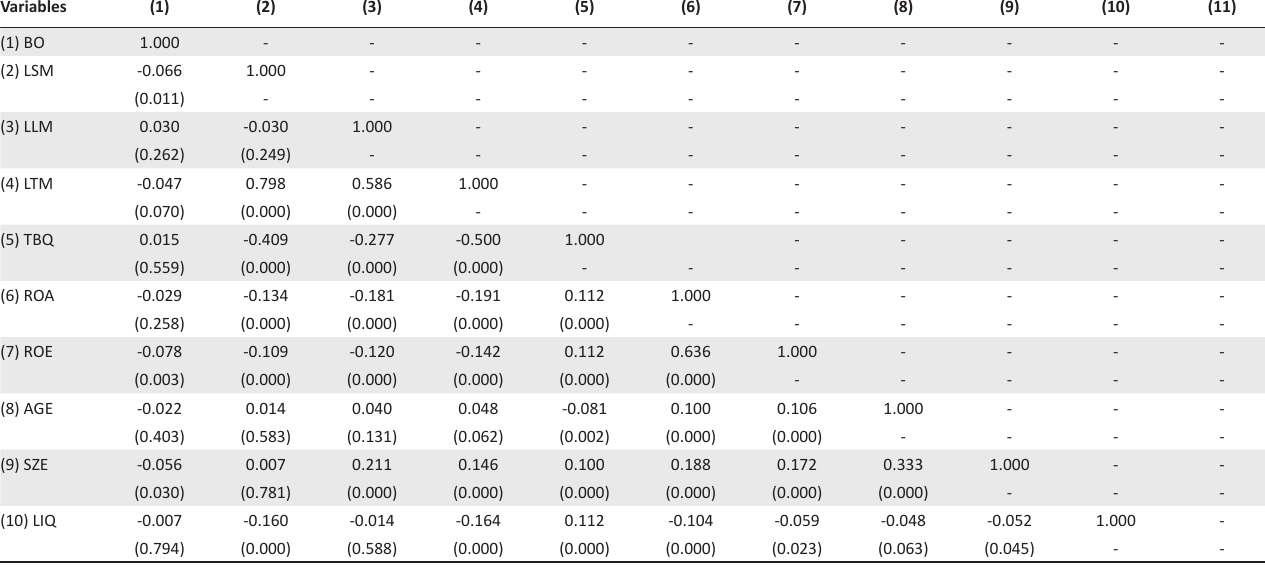
TABLE 3: Correlation matrix of the variables.